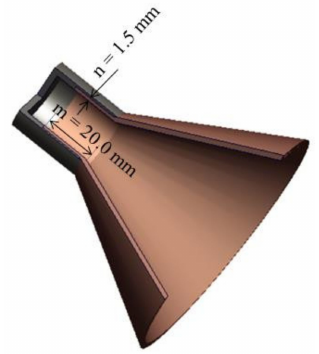
Figure 8. The connection method of the cylindrical liner and the truncated